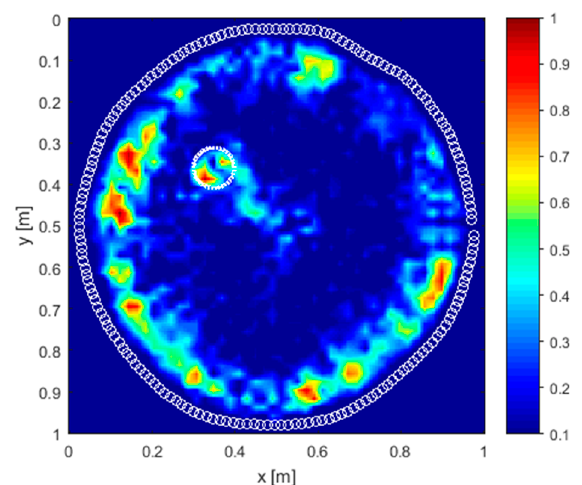
Figure 6. Radargrams of the simulations for the softwood tree scenario. ( a ) Raw radargam; ( b ) processed radargram after the application of the pre-processing stage.